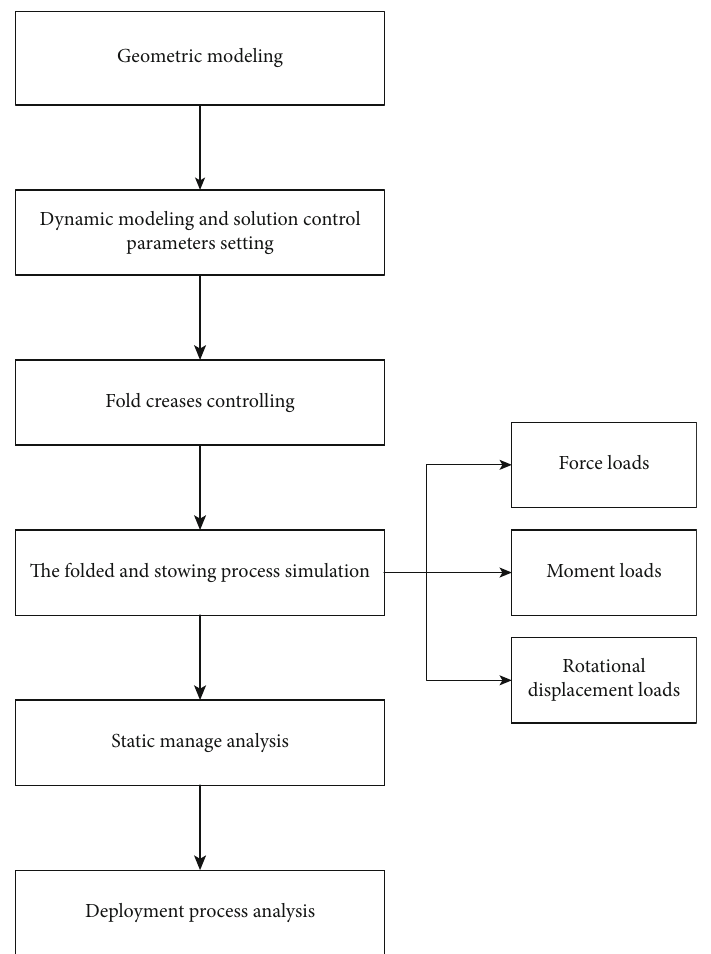
Figure 4: Flow chart of stowing and deployment process analysis.